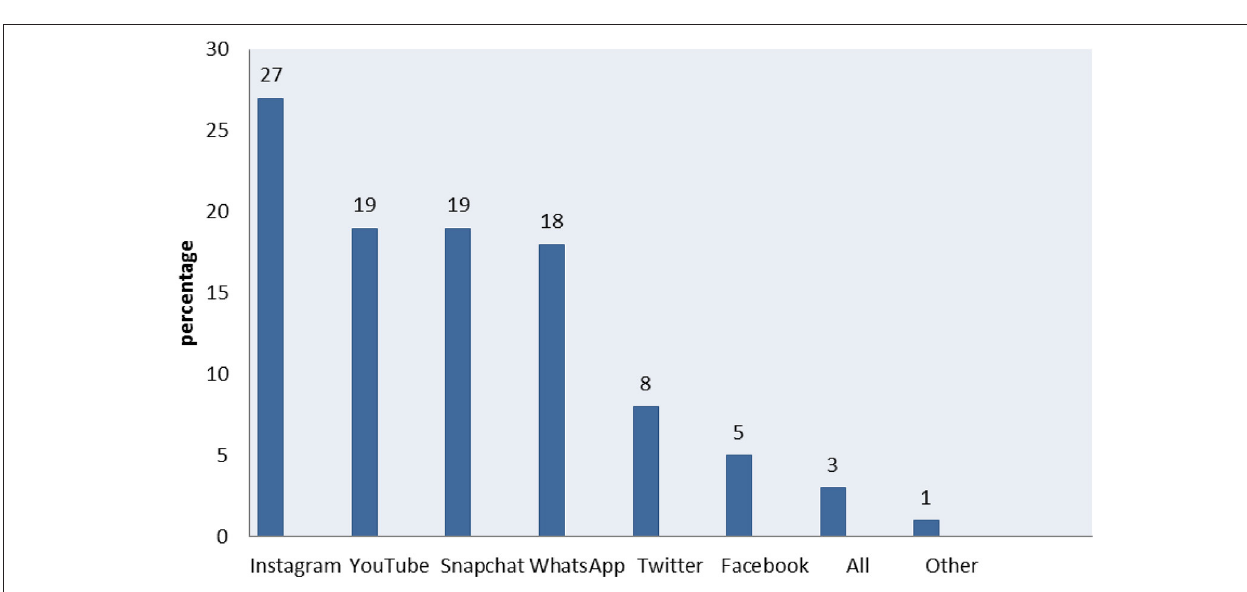
Frontiers in Public Health |